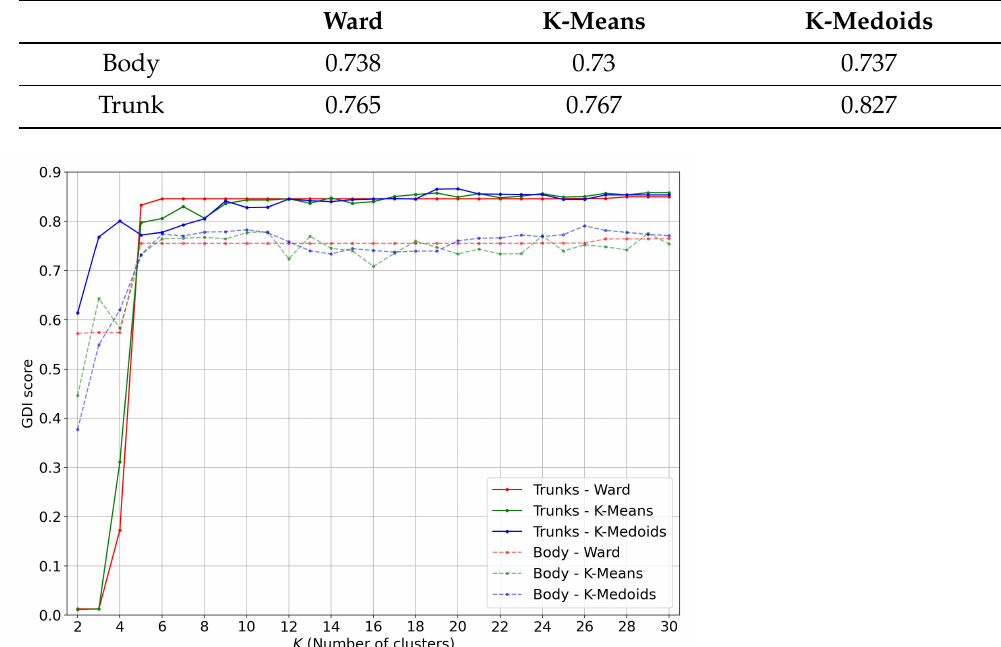
Table 2. Average GDI scores on the persistence silhouettes of the whole body and the trunk.